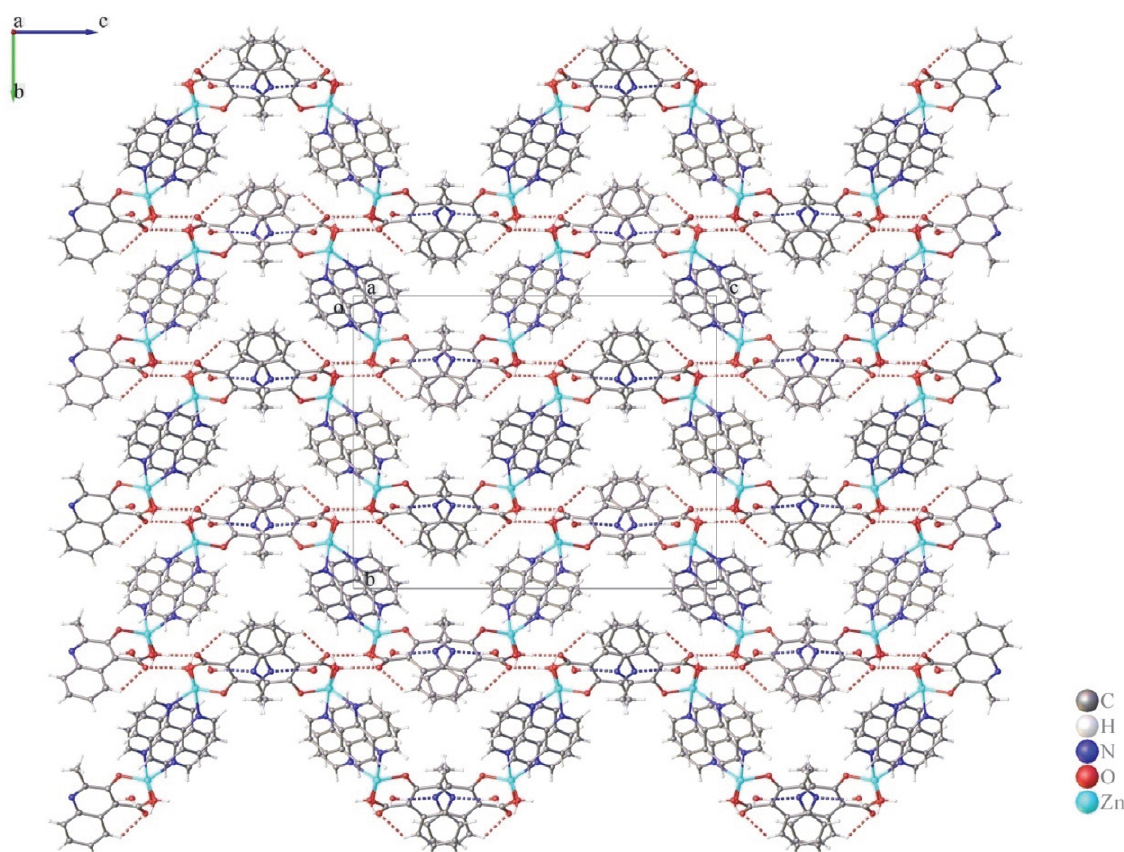
Fig. 3. The packing diagram of the title complex with the dashed lines representing the hydrogen bonding interactions. Symmetric code: (i) ½ + x , 3 /